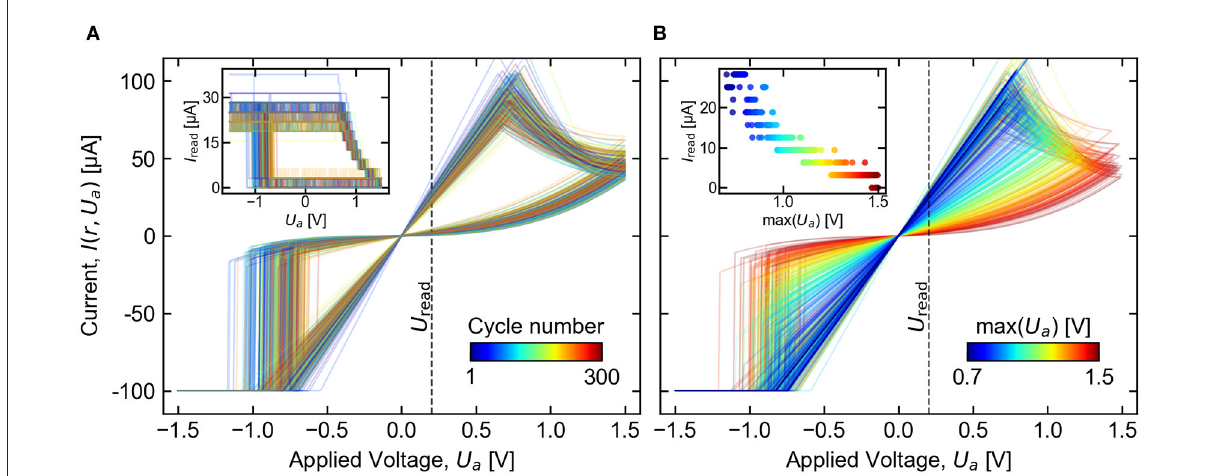
FIGURE13 Two example simulations involving repeated cycling of a single device. Voltage pulse sequences were applied with varying amplitude following a triangular envelope, and the ( I , U ) characteristic of each cycle is plotted in a different color. Subplot (A) shows 300 consecutive cycles between the full voltage range 1.5 V, with a readout performed after every pulse (inset). Subplot (B) demonstrates multilevel capability with 300 cycles ± between –1.5 V and maximum voltage that increases each cycle, from 0.7 V to 1.5 V. Readouts following each cycle are shown in the inset. In each case, readouts were simulated using a fixed U read 200 mV, including noise and 4-bit quantization between I min =